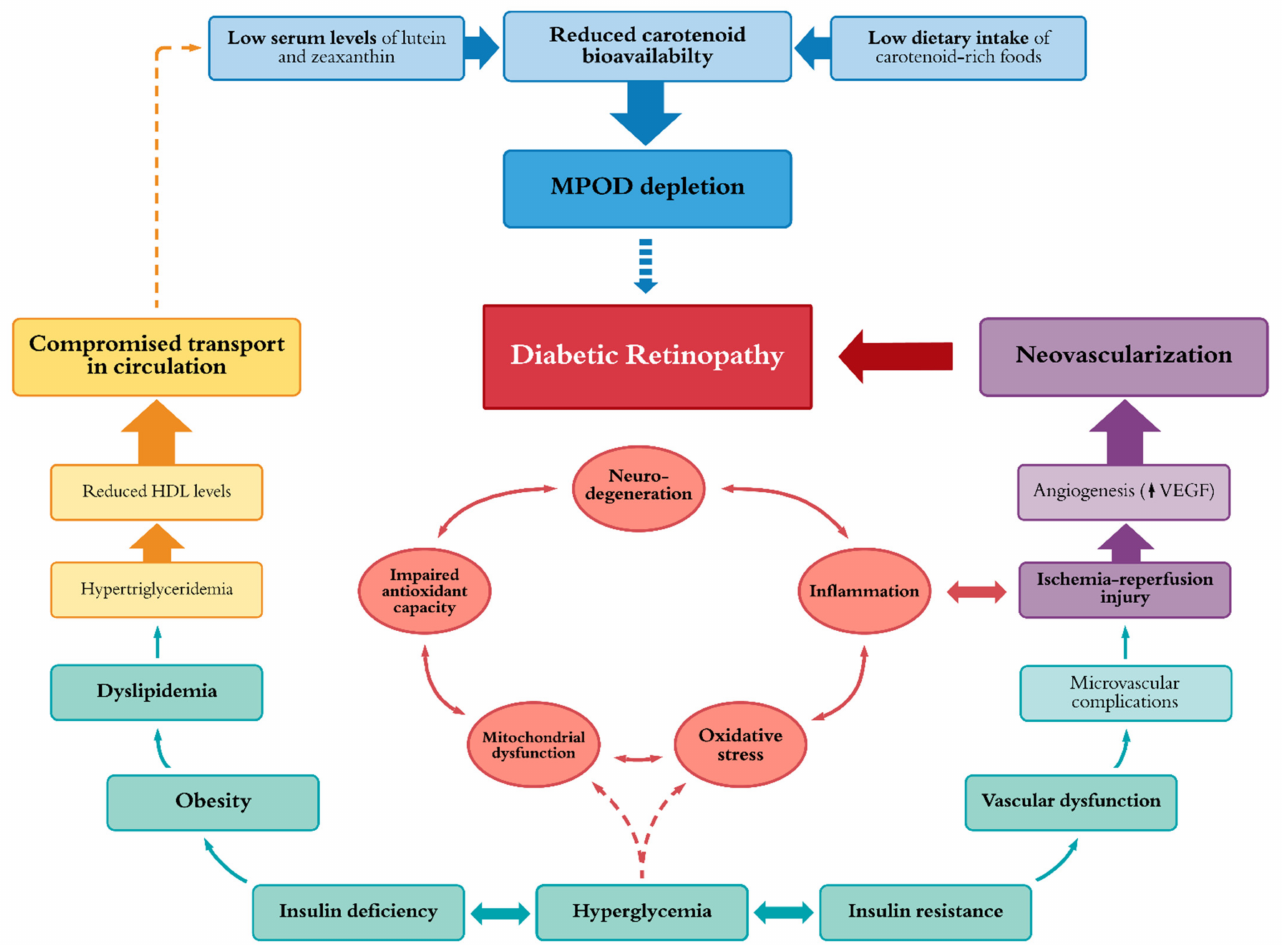
Figure 5. Schematic overview of proposed causative mechanisms and metabolic perturbations implicated in diabetic retinopa- thy. MPOD, macular pigment optical density; HDL, high-density lipoprotein; VEGF, vascular endothelial growth